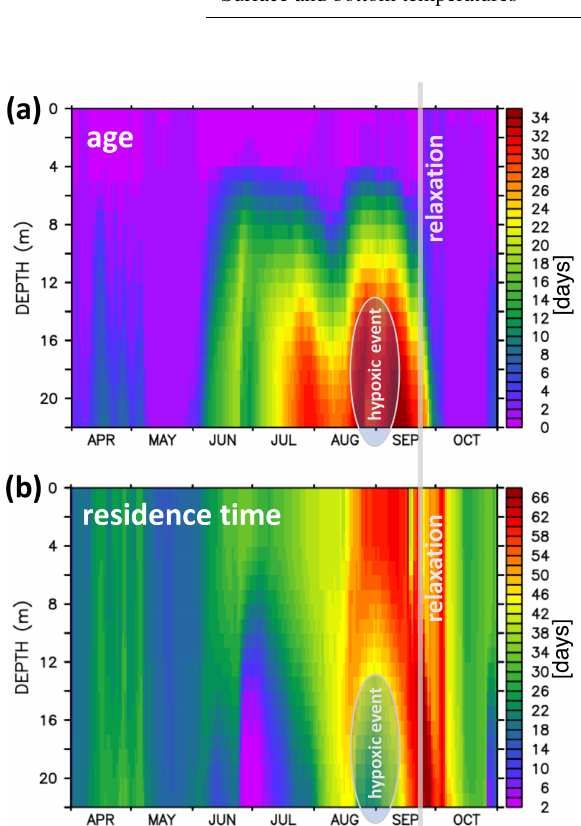
Figure 14. Hovmöller diagrams of simulated water age and res- idence time at the monitoring station Buoy 2a ( a and b , respec- tively). The oval marking in August–September highlights the 2017 hypoxic event. The vertical gray line marks the start of the relax- ation phase ending the hypoxic event.